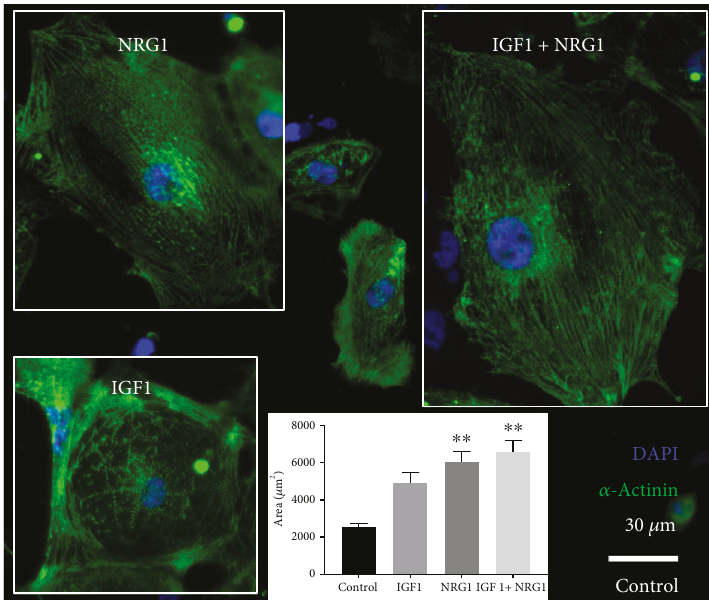
Figure 7: NRG1 treatment stimulates growth in single hESC-cardiomyocytes. Immuno fl uorescence of α -actinin (green) and nuclei (blue) in control (center), IGF1 (bottom left), NRG1 (top left), or IGF1+NRG1 (top right) treated hESC-cardiomyocytes. Area was measured for each group (bottom center). n ≥ 38 cells analyzed per group; data are expressed as mean ± SEM. ∗∗ P < 0 01